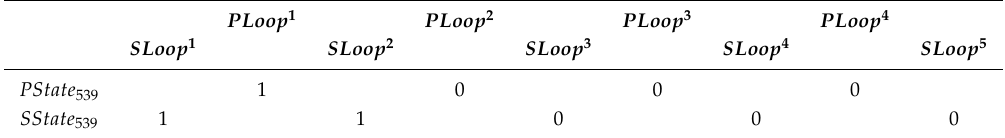
Table 1. Mathematical form of states in frame 539.